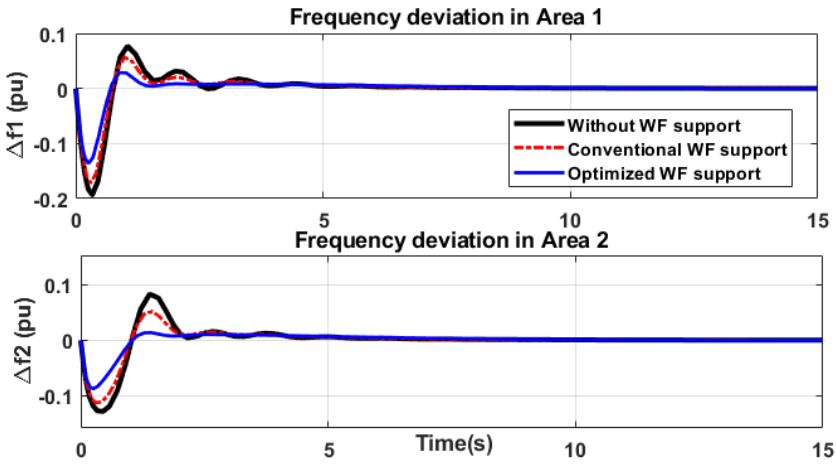
Figure 11. Frequency deviation in a Poolco